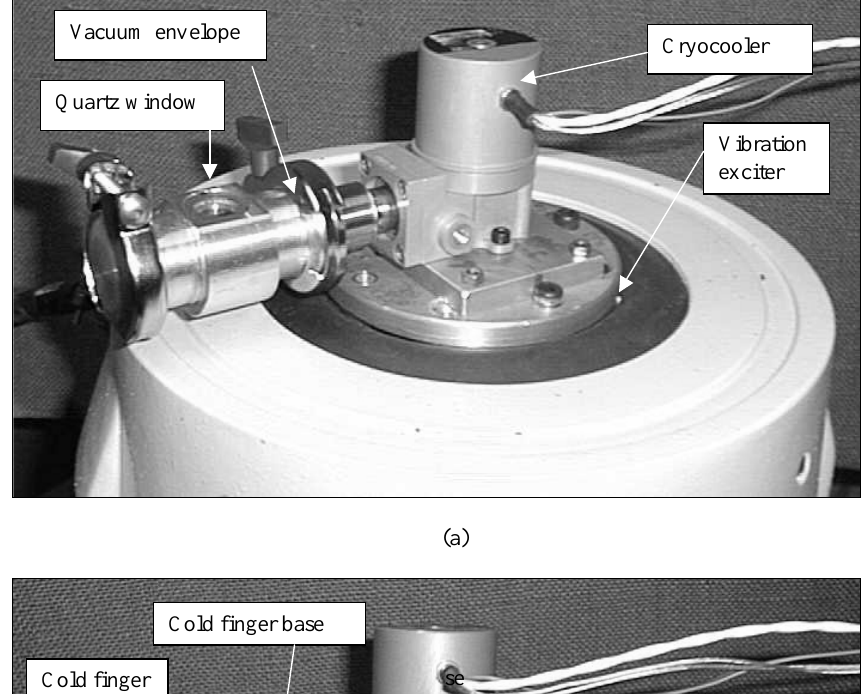
Fig. 7. Layout of experimental